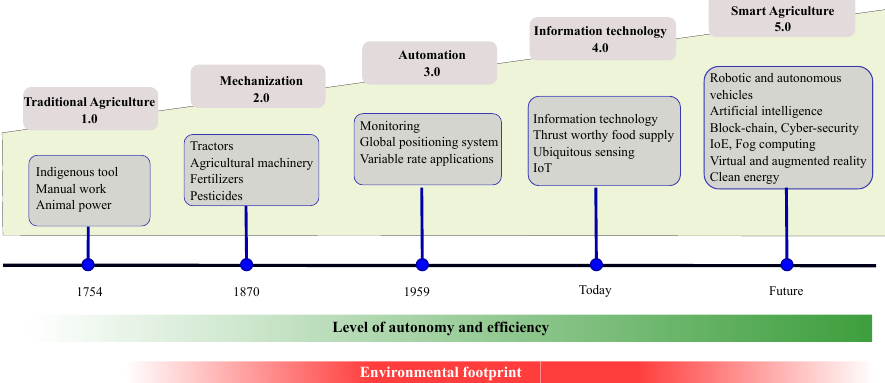
Figure 1. Development roadmap for the agricultural revolution from Agriculture 1.0 to Agriculture 5.0